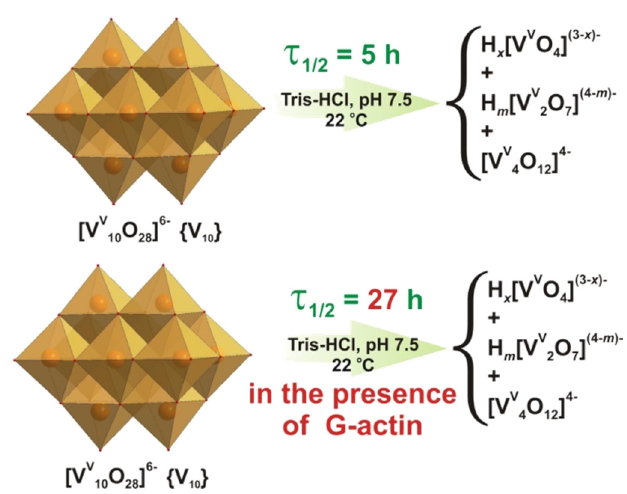
Figure 5. POM species in the presence of macromolecules. Decavanadate, an isopolyoxovanadate, was found to be stabilized upon interaction with G-actin and Ca 2+ -ATPase [124].